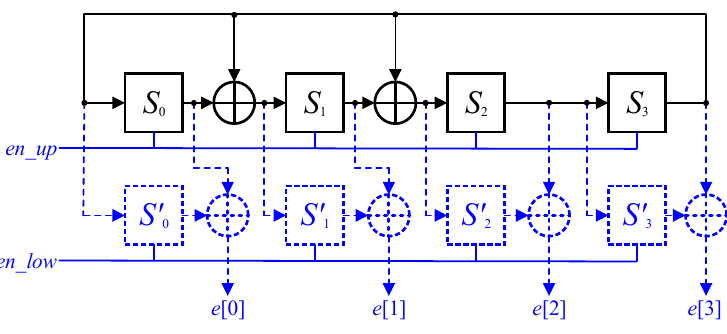
Figure 3. Example of time redundancy method [31,32].